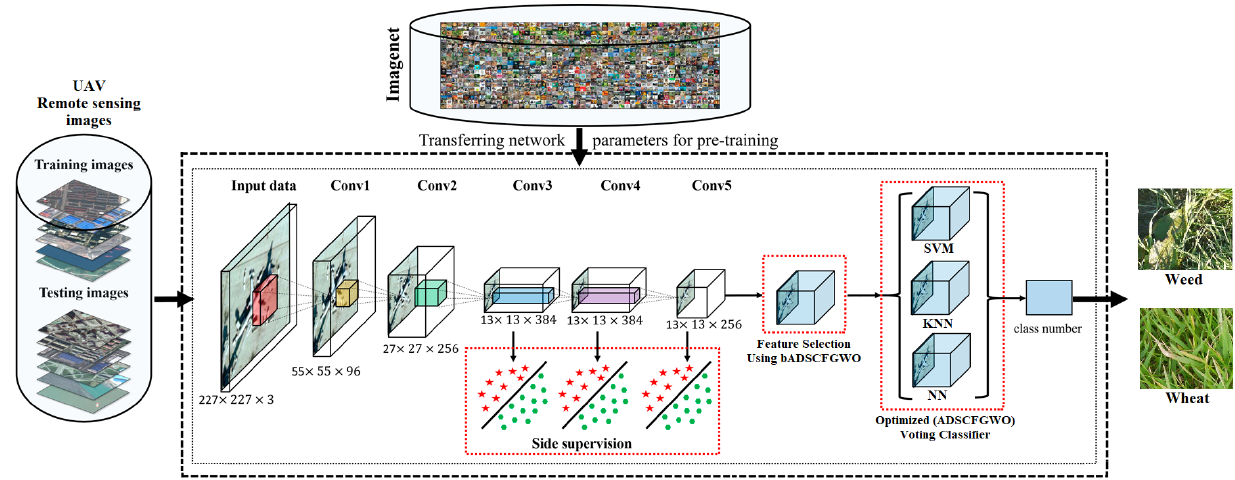
Figure 4. The proposed methodology for weed/wheat